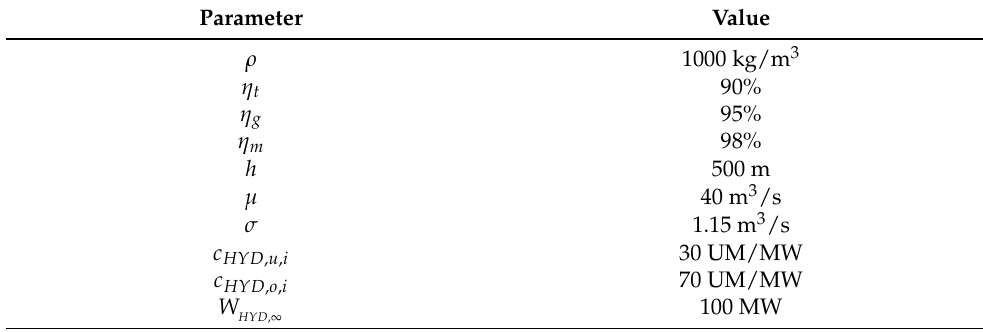
Table 10. Parameters taken for the cost function of the run-of-river hydroelectric plant [5].